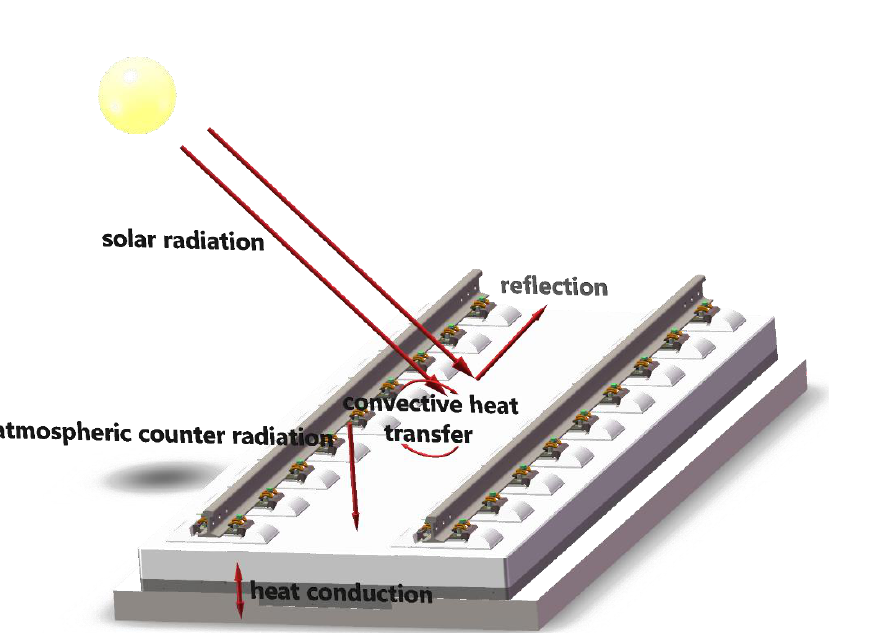
Figure 2. Schematic diagram of the heat exchange process of the ballastless track.